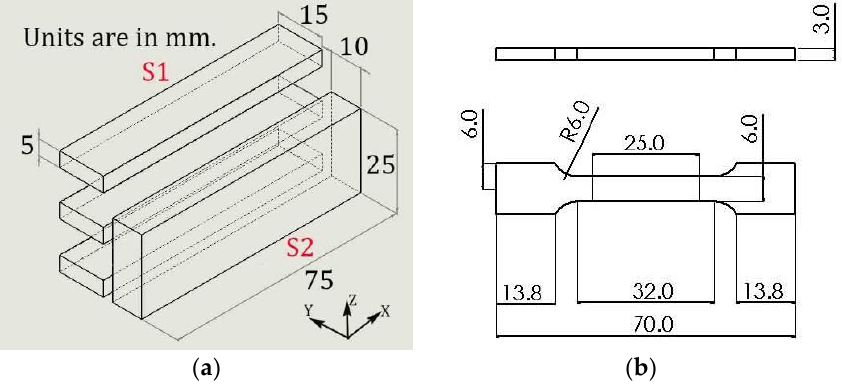
Figure 4. Schematic diagrams showing ( a ) extraction methodology, and ( b ) the geometry of the tensile samples.